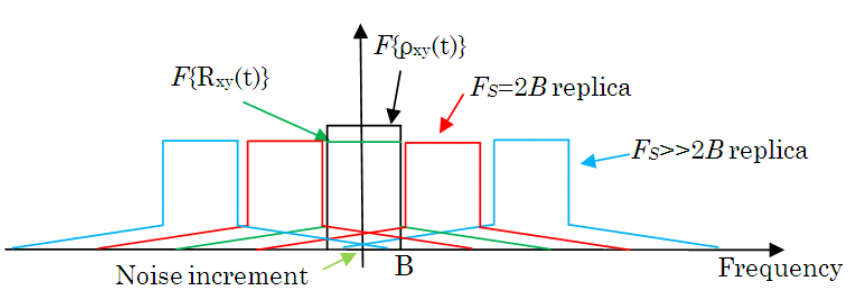
Figure 8. Effect of the sampling on the correlation spectrum, ( F {·} stands for Fourier transform). Spectrum of the ideal and the quantized correlation at baseband, black and green, respectively. In red, it is the first spectrum replica for the minimum sampling frequency which fulfills the Nyquist criterion ( F s = 2B). In blue, it is the first spectrum replica for F s >>